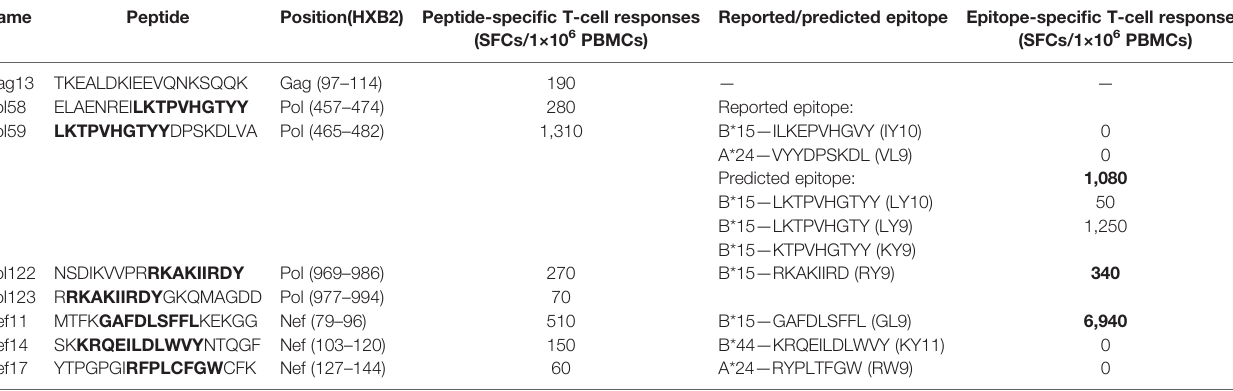
TABLE 1 | T-cell responses targeting 18-mer OLPs spanning the Gag, Pol, and Nef proteins of the HIV-1 CRF01_AE subtype after